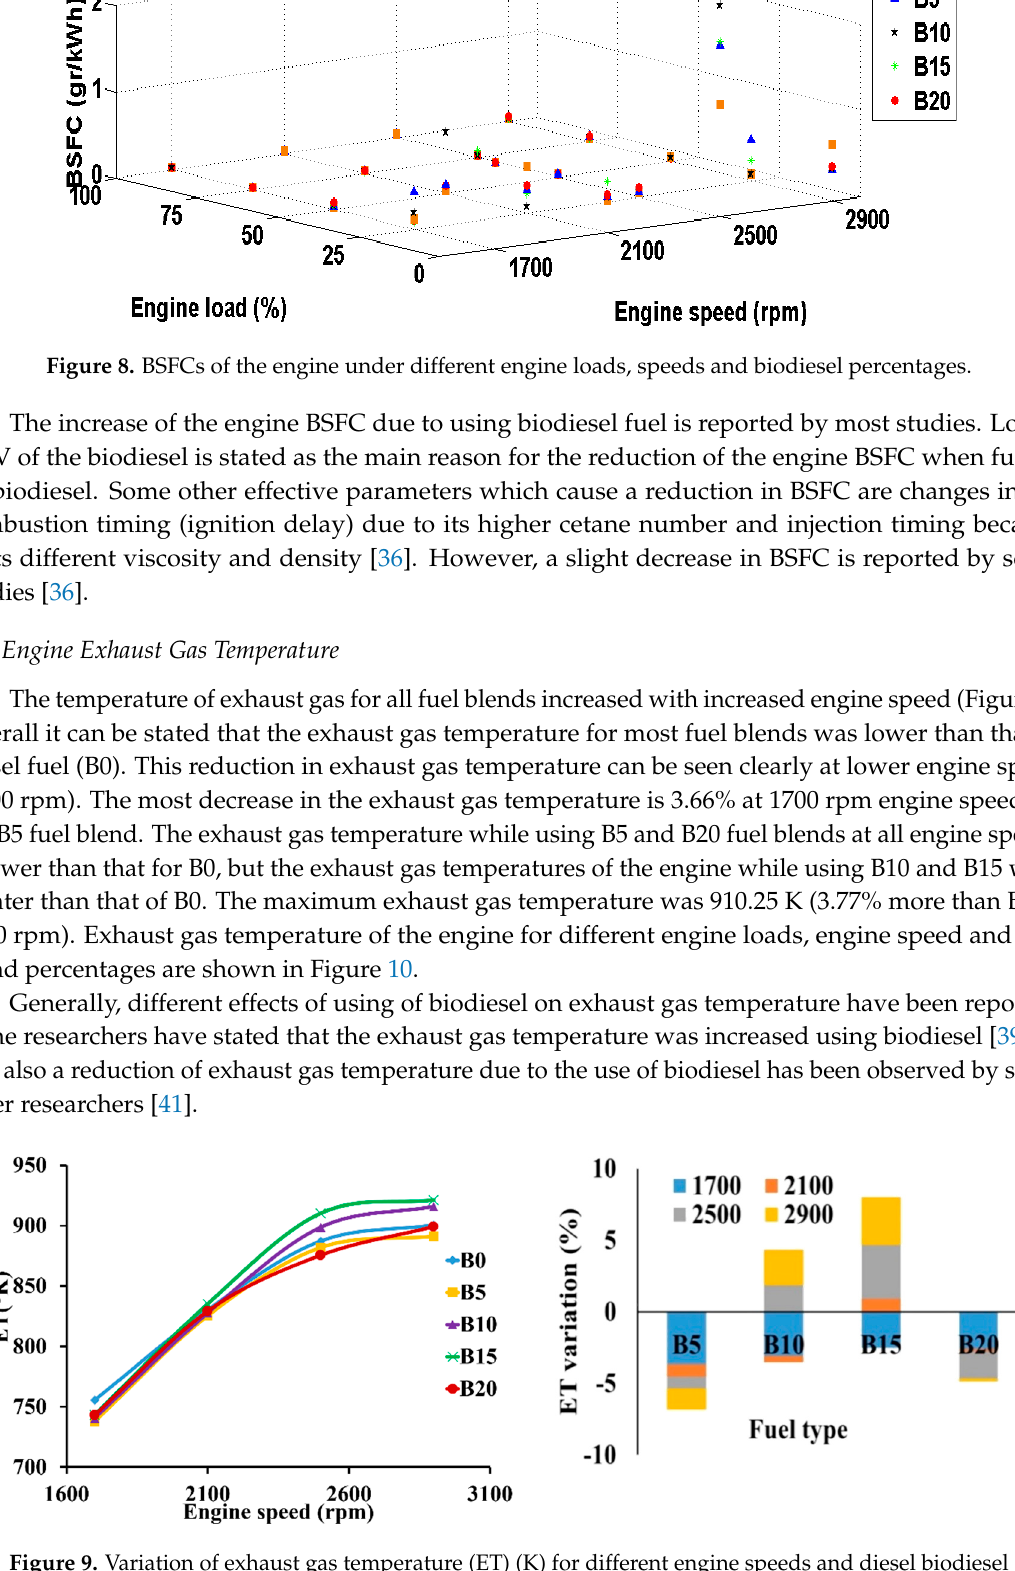
Figure 9. Variation of exhaust gas temperature (ET) (K) for different engine speeds and diesel biodiesel blends at full load.